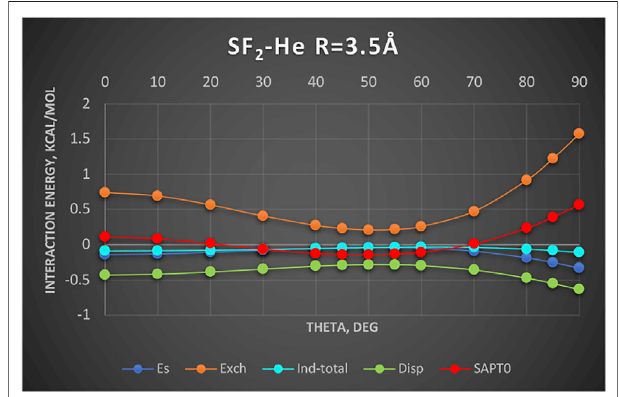
FIGURE6| SAPT0energycomponentsofSF 2 -Heasafunctionoftheta. Complex is described in Jacobi coordinates: R = 3.5 Å and theta = 0 ° corresponds to He located at the C 2 axis on the S side. Values in